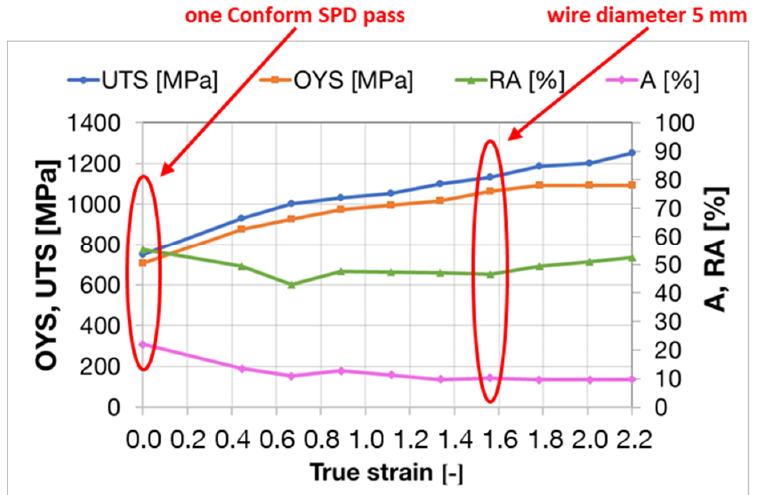
Figure 16. Results of tensile testing for titanium Grade 4 after one Conform SPD pass and rotary swaging as a function of the true strain induced by rotary swaging.